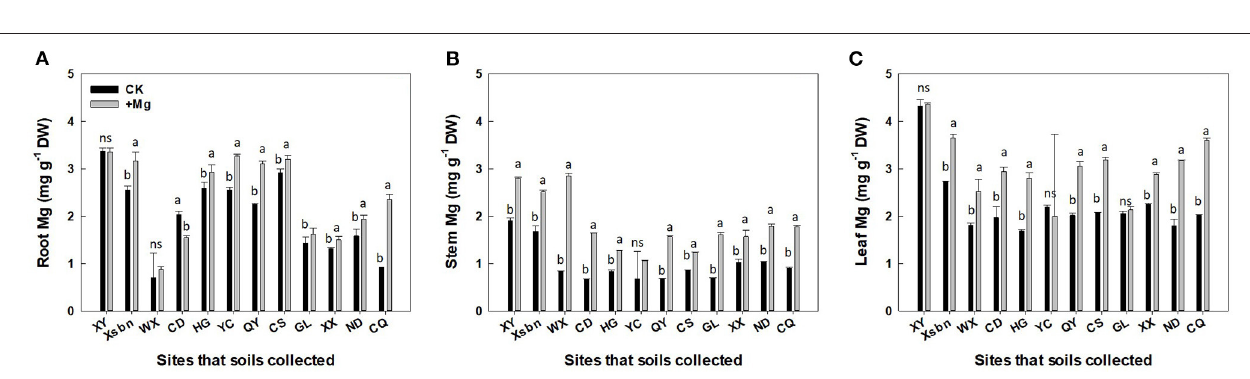
FIGURE 2 | Concentration of magnesium (means ± SD, n = 3) in root (A) , stem (B) , and leaf (C) of tea plants. Here “ns” and different letters above the bar indicate insignificant and significant ( p < 0.01) differences, respectively, between two magnesium treatments. XY, Xsbn, WX, CD, HG, YC, QY, CS, GL, XX, ND, and CQ indicated that the soil has been collected in the site of Xinyang, Xishuangbanna, Wuxi, Chengdu, Huanggang, Qingyuan, Changsha, Guiling, Xiangxi, Ningde and Chongqing, respectively.